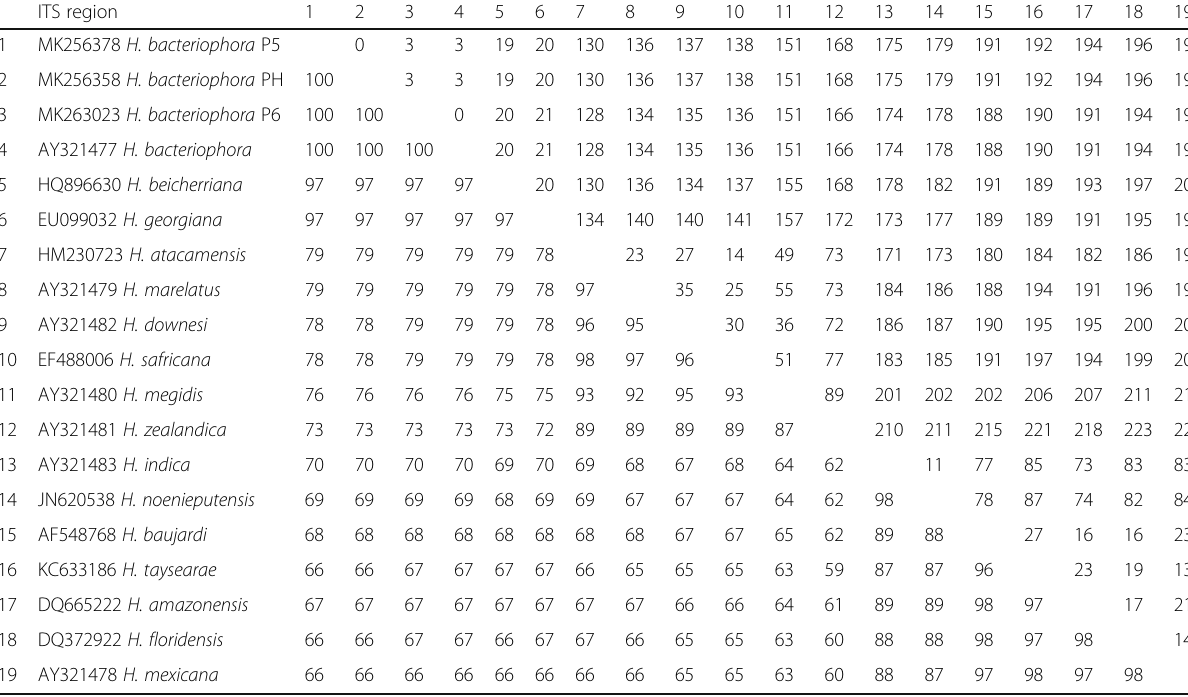
Table 3 Pairwise distances of the ITS rDNA regions between Heterorhabditis species. Below diagonal: percentage similarities; above diagonal: total character differences ITS